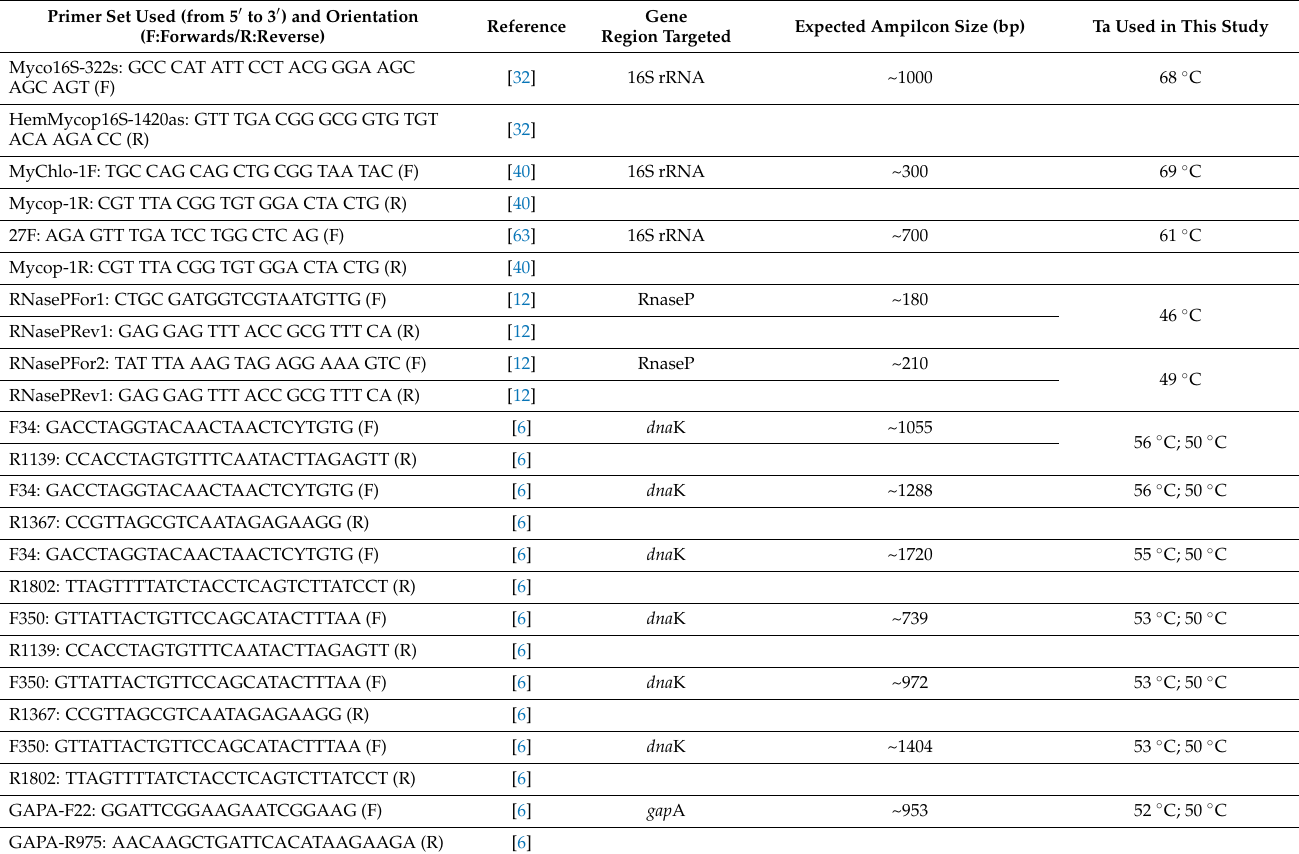
Table 2. PCR assays used to screen Rattus kidney, buccal swabs, and associated ectoparasites for haemotropic Mycoplasma